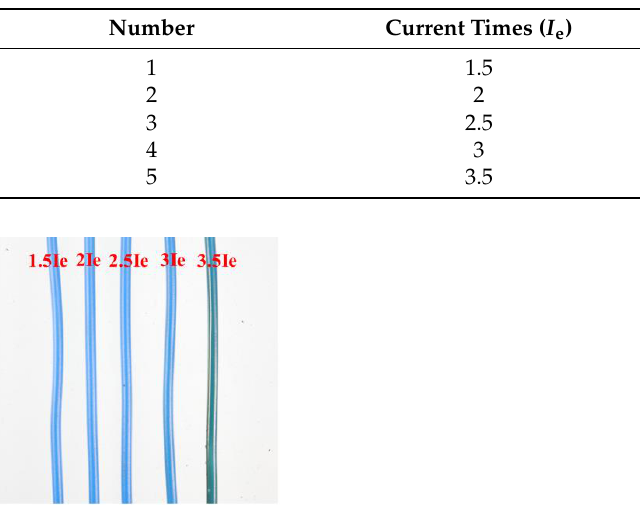
Figure 2. Various overload current PVC copper wires.